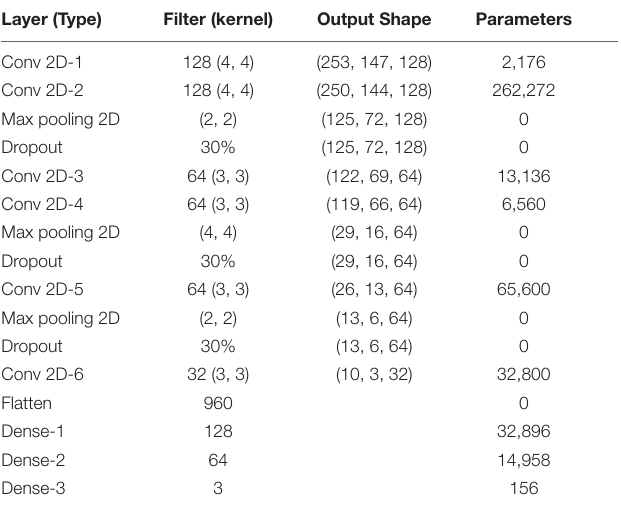
FIGURE 5 | Overview of CNN model usage after converting 3D data to 2D data. TABLE 1 | 2D CNN model architecture.